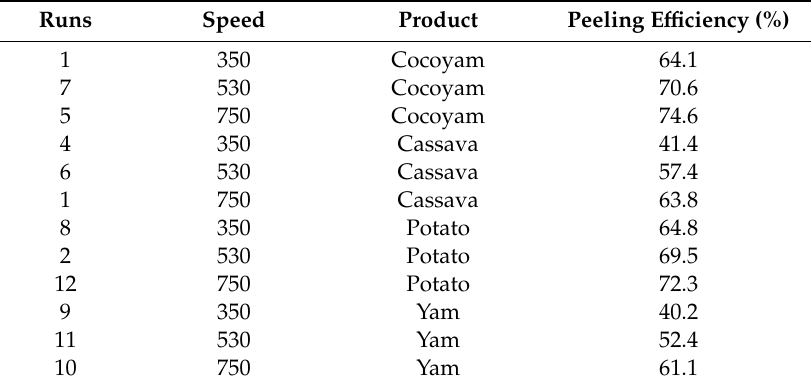
Table 6. Effect of shaft speed on the peeling efficiency.